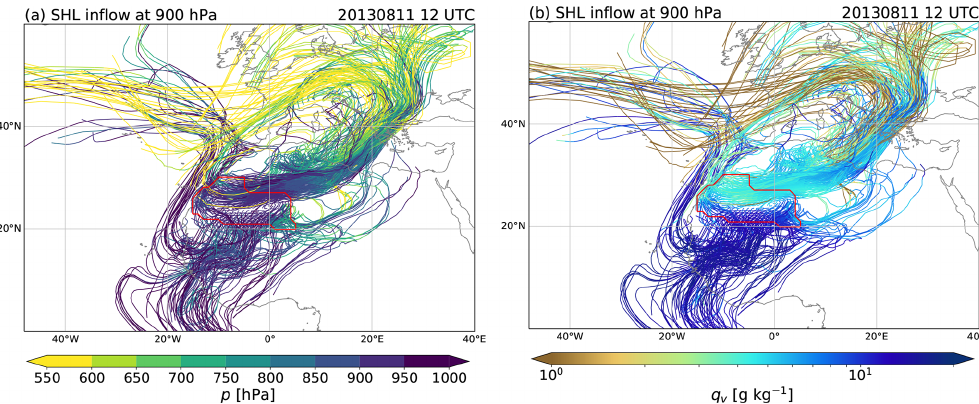
Figure 11. Exemplary inflow into the Saharan heat low at 900hPa. The ERA-Interim trajectories were started every 100km from the 900hPa level in the heat low (red contours) at 12:00UTC 11 August 2013 and are run 10d back in time. The starting time corresponds to the time at which air parcels in Fig. 10a and b are located in the Saharan heat low (approximately 3d before arrival). The Lagrangian evolution of the air parcels’ pressure p is shown in (a) and of the specific humidity q v in (b) .